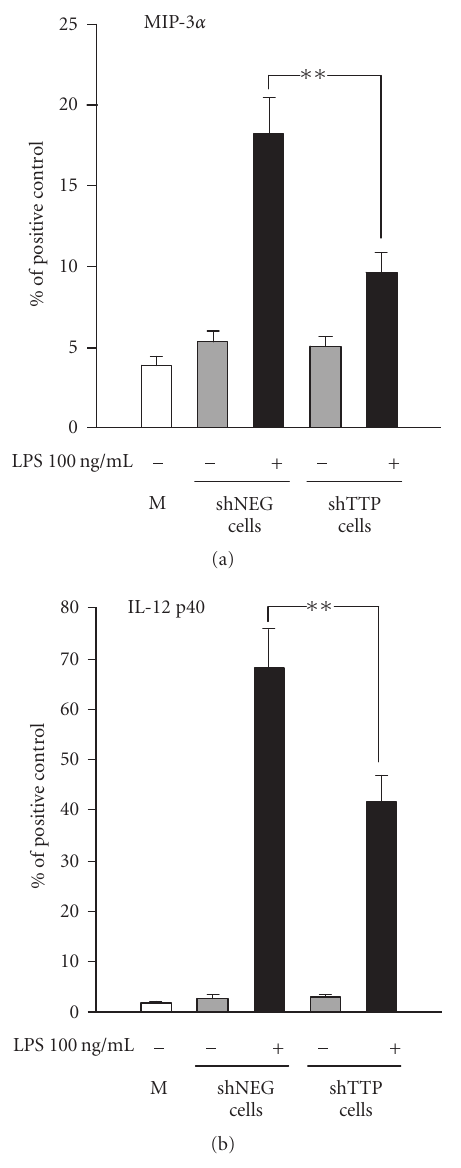
Figure 4: TTP down-regulation (shTTP cell line) reduced the pro- duction of MIP-3 α and IL-12 p40 subunit in response to LPS. Cy- tokine antibody array membranes were incubated in medium con- trol (M) or in media from cell cultures of TTP knock-down cells (shTTP cell line) or control cells (shNEG cell line) after treatment with or without LPS (100ng/mL). Values are arbitrary units com- pared to positive controls (100) and are presented as mean ( n = 3). (cid:2)(cid:2) = P < .